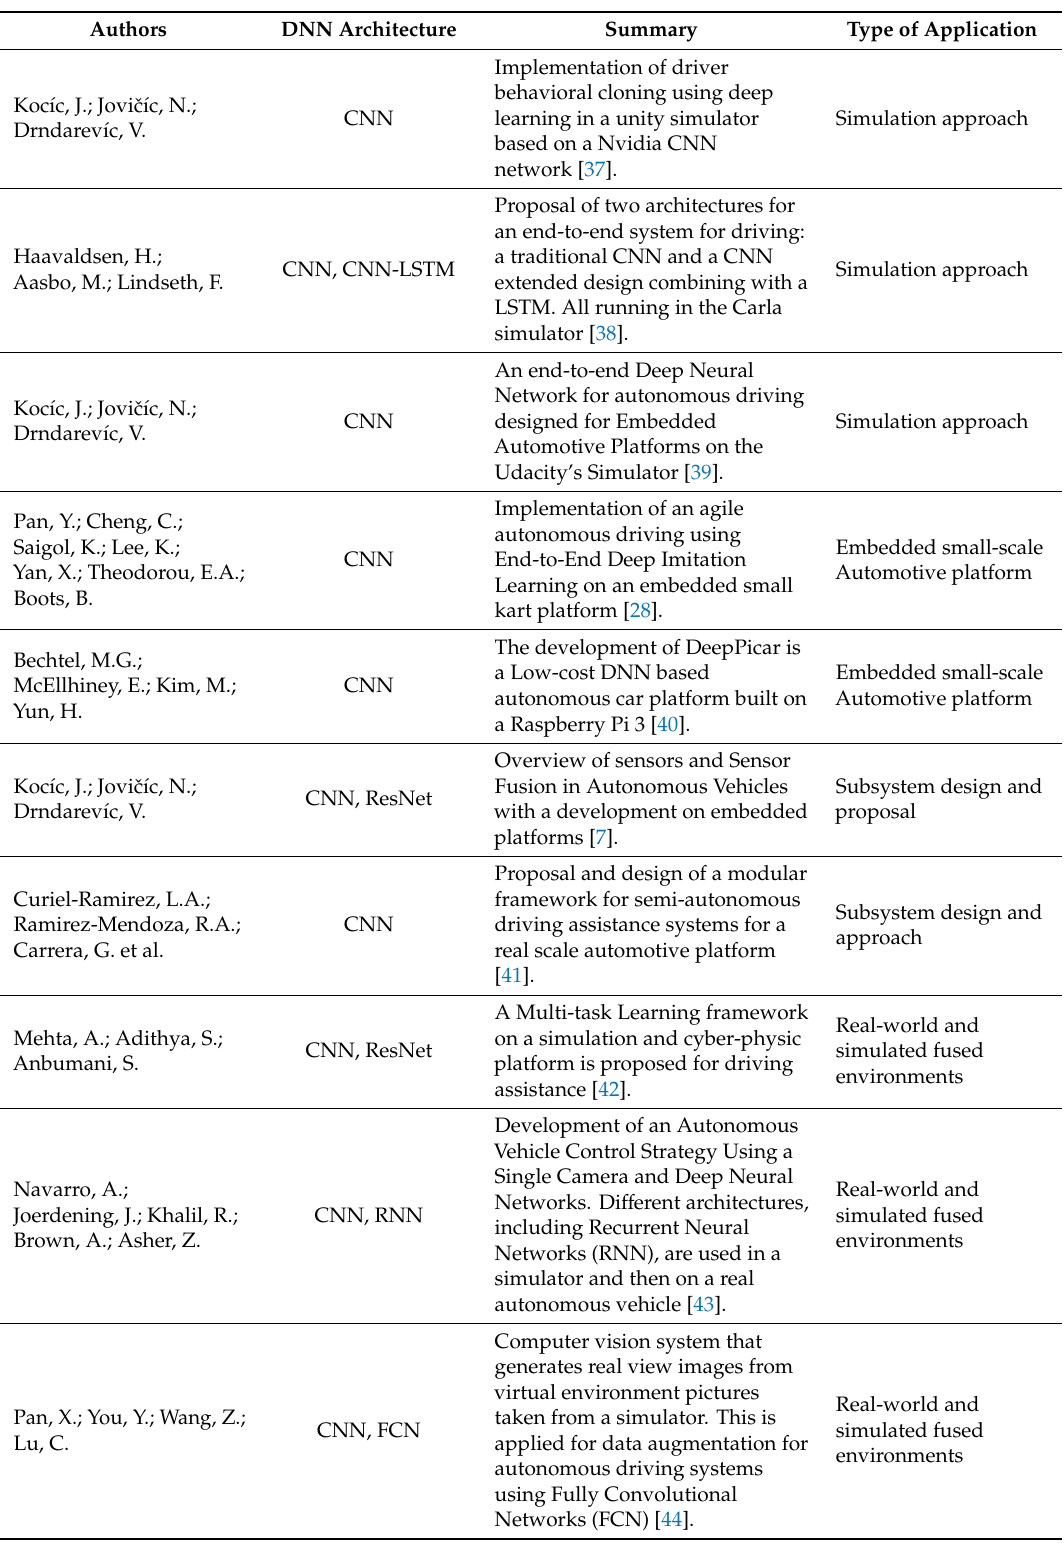
Table 2. Summary of state-of-the-art Deep Learning (DL)